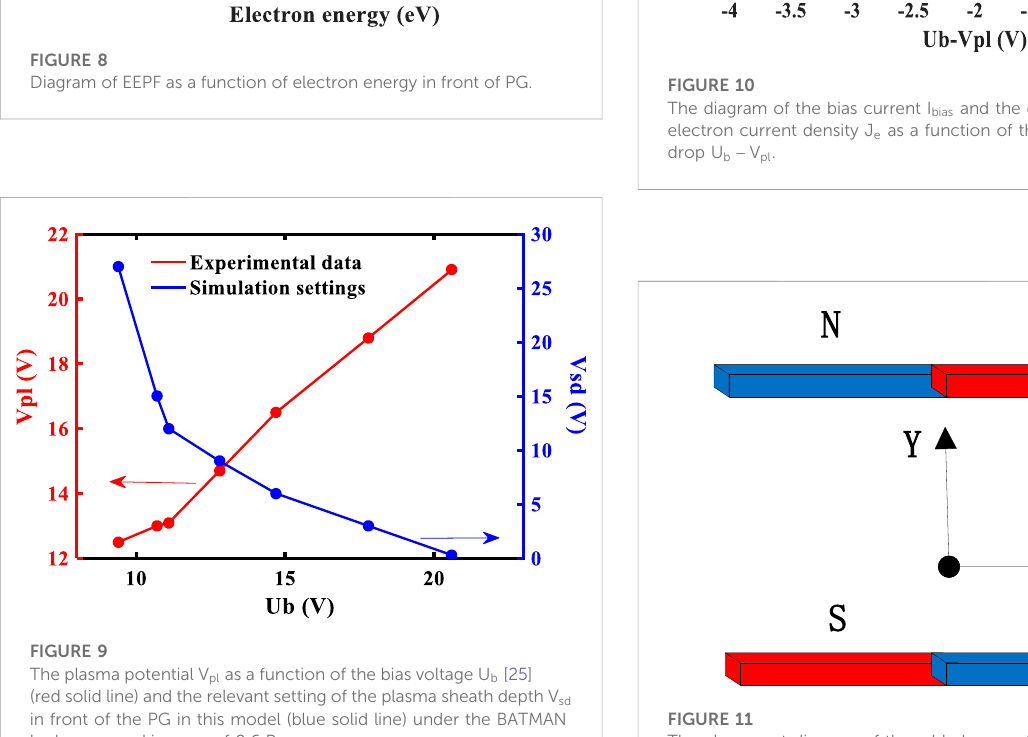
FIGURE 11 The placement diagram of the added